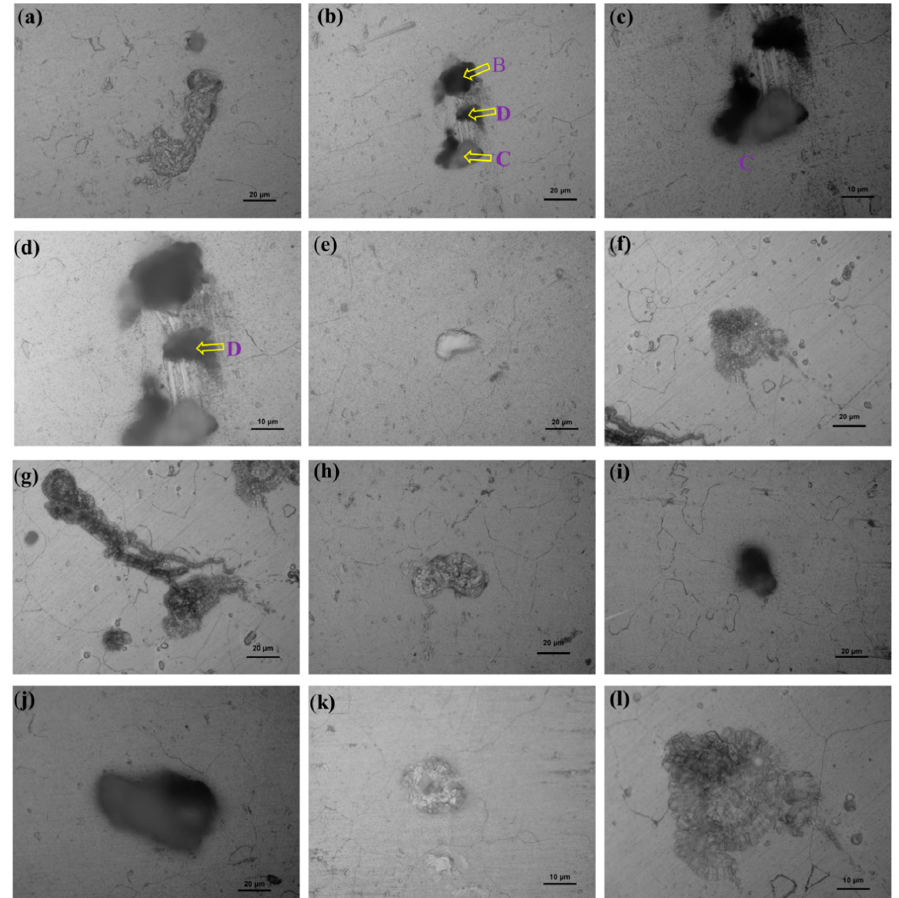
Figure 4. Optical morphologies of pits observed on Sample-Z after constant immersion: ( a – k ) are the selected pitting points from A to K listed in Table 2, and ( l ) is the amplified region of ( f ), highlighting the caved grains along the grain boundaries.